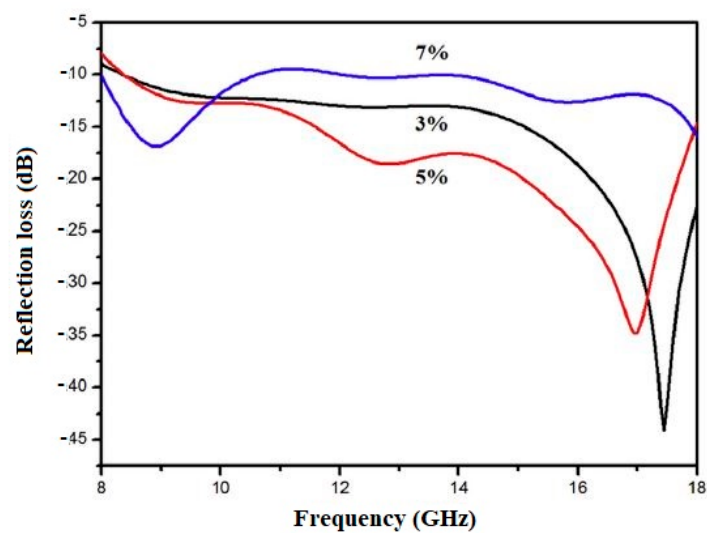
Figure 20. Reflection loss versus frequency for a cement composite containing 5% nano-Fe 3 O 4 magnetic fluid, nano-Fe 3 O 4 powder, and bulk Fe 3 O 4 powder (Reprinted with permission from [94]).